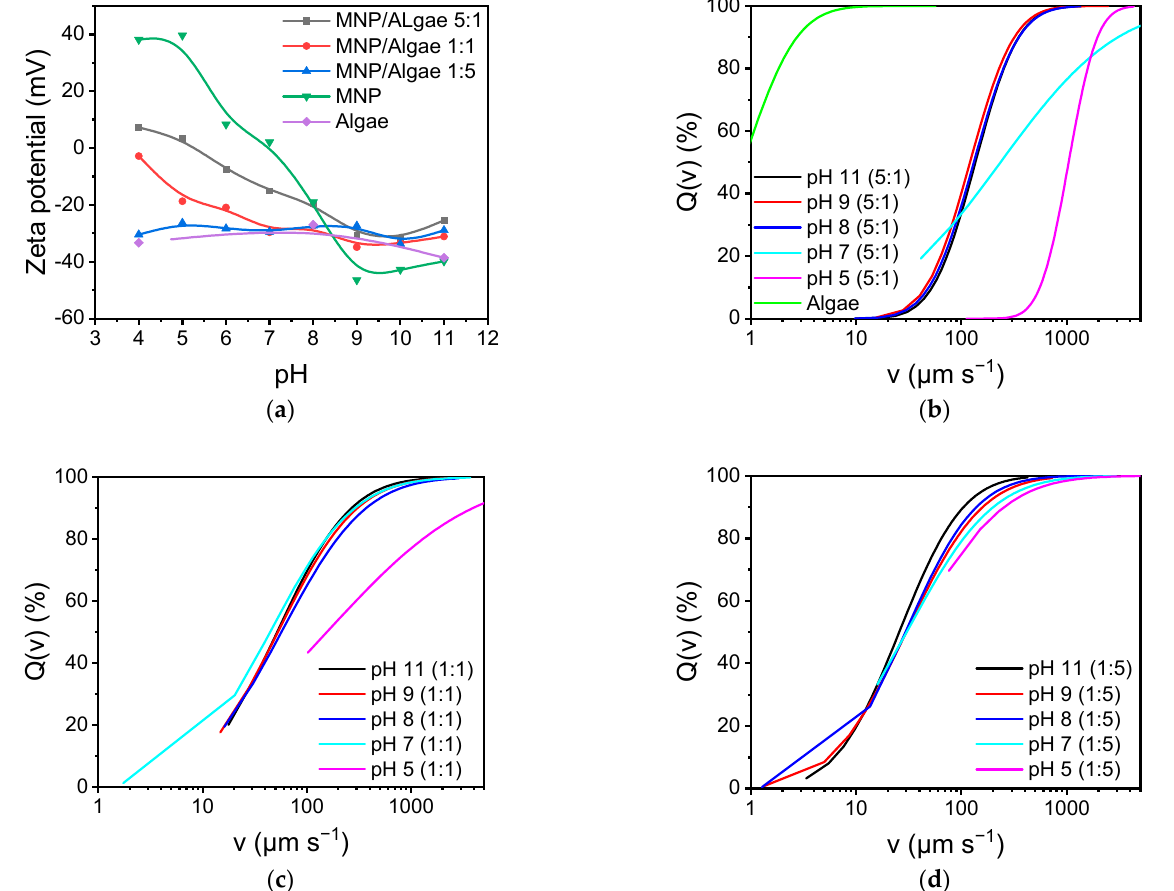
Figure 4. ( a ) Zeta potential of iron oxide nanoparticles (2 g/L) mixed with algae over the pH range 4–11 at 25 °C in sucrose containing water (24.4 w%). Cumulative distribution of sedimentation velocity of MNP and algae mixtures. ( b ) 5:1, ( c ) 1:1, and ( d ) 1:5. While the flow of the magnetic nanoparticles (2 g/L) is not affected without a mag ‐